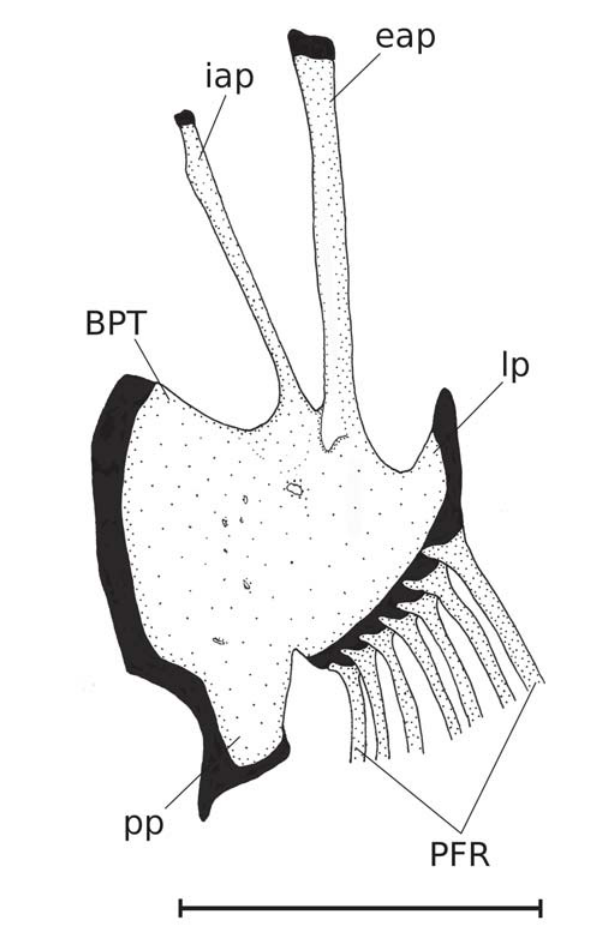
Fig. 12. Pelvic girdle of Leptodoras oyakawai , based on MZUSP 95722, 73 mm SL, in dorsal view. BPT basipterygium, eap external anterior process of BPT, iap internal anterior pro- cess of BPT, lp lateral process of BPT, PFR pelvic-fin rays, pp posterior process of BPT. Scale bar 5